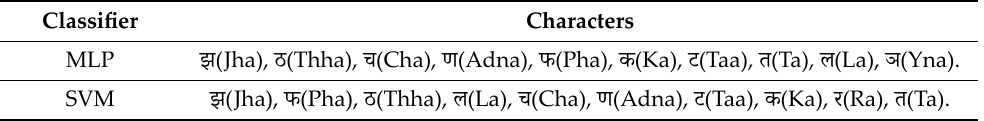
Table 15. Mean F1 score‑wise top 10 characters, including all the 15 datasets.